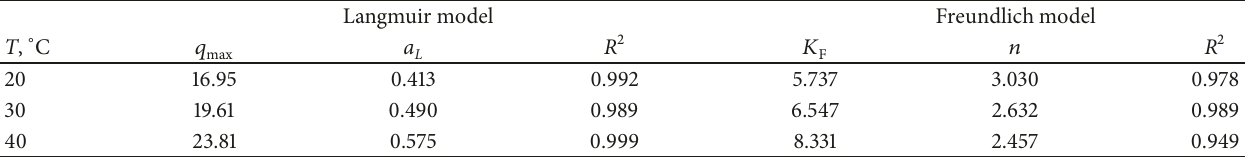
Table 2: Isotherm coefficients for BG adsorbed onto the poly(VP-co-An)/zeolite. Langmuir model